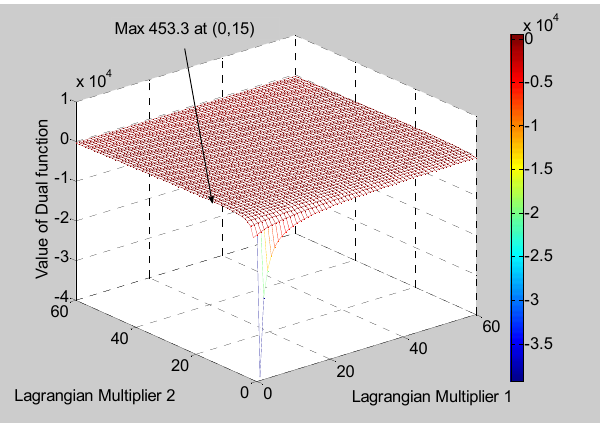
Figure 6. Dual function for a Target Scenario 2.